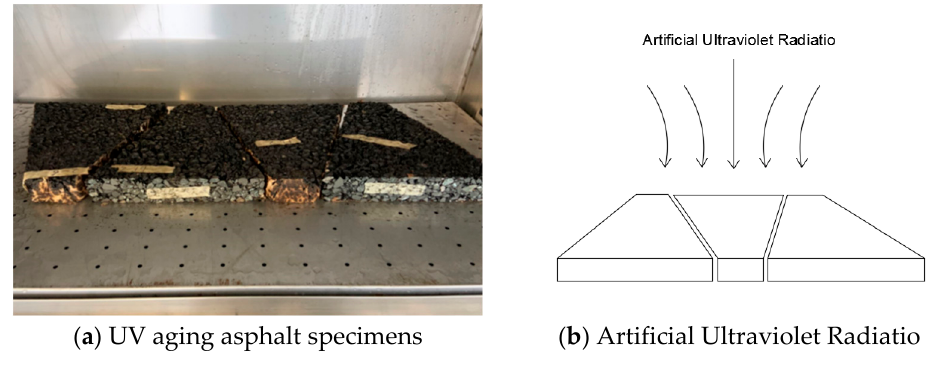
Figure 1. UV aging test.